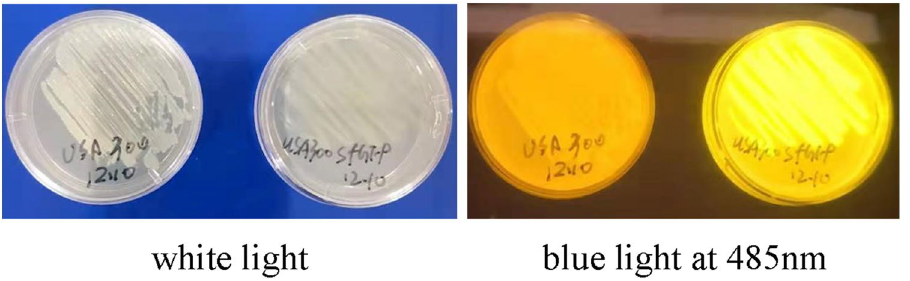
Figure 1. Original USA300 strain (left plate) and GFP-transgenic USA300 strain (right plate) under white light (left picture) and blue light at 485 nm (right